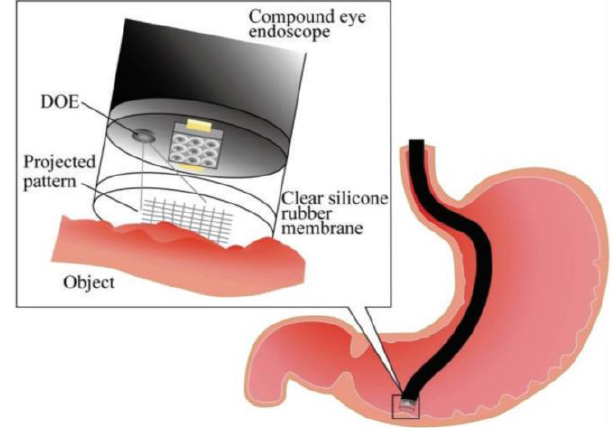
Figure 29. Overview of compound eye-type tactile endoscope.